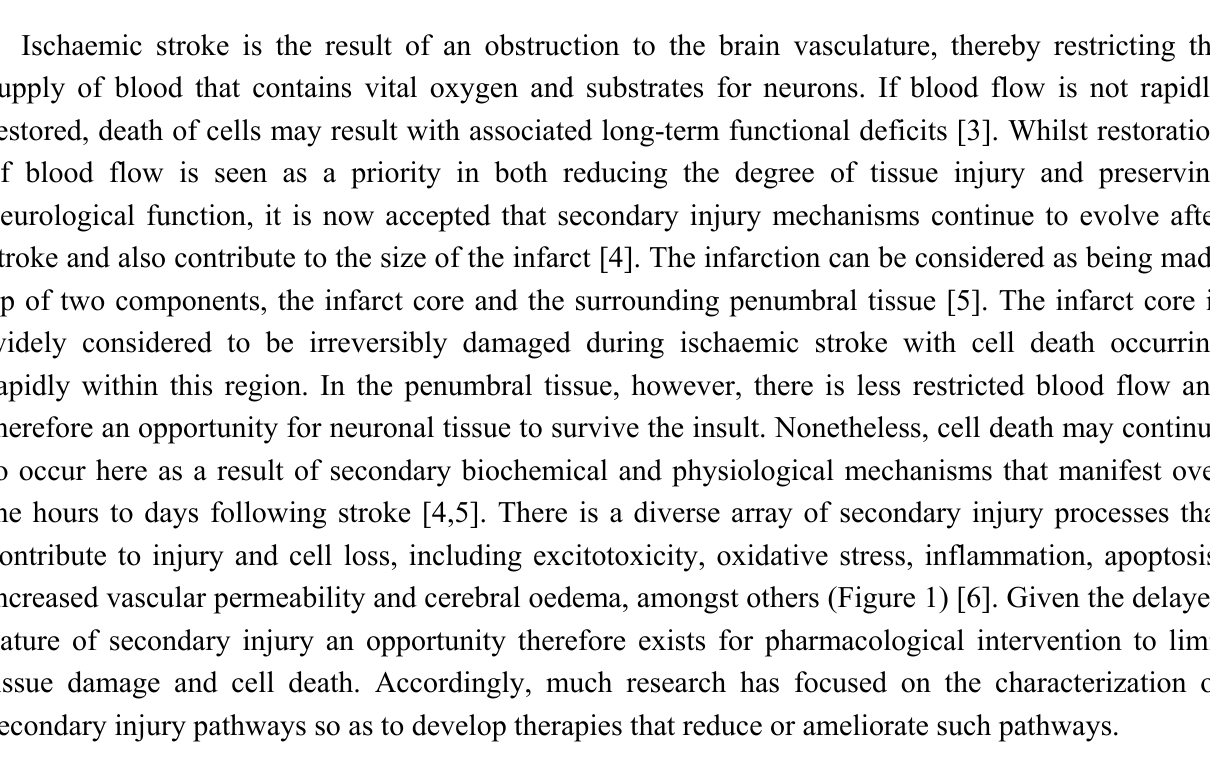
Figure 1. Secondary injury pathways that occur following ischaemic